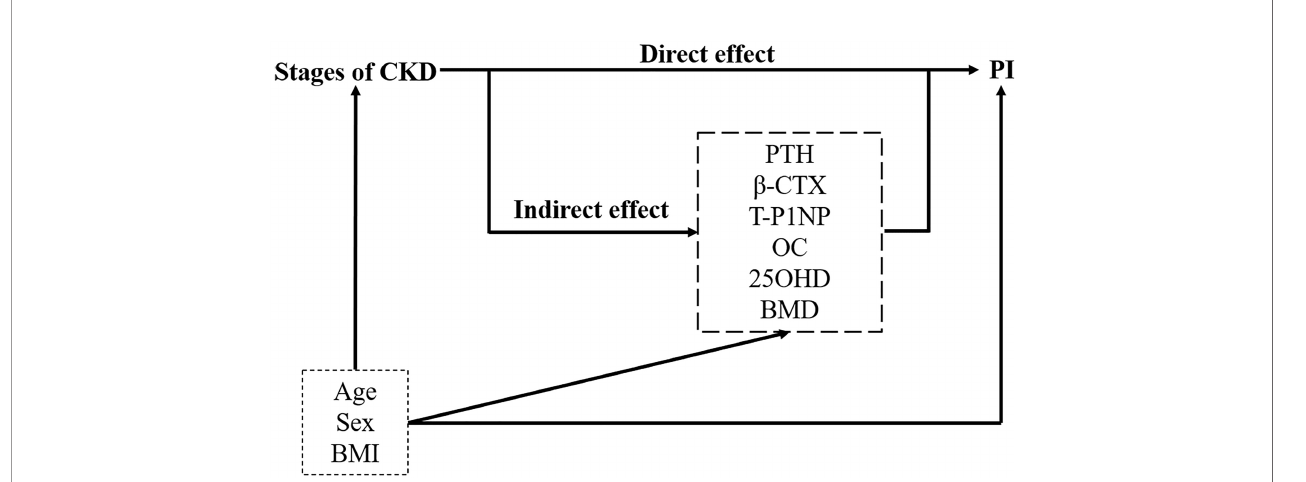
FIGURE 2 | Path diagram of the mediation relationship between grouping (the stages of CKD), mediators (bone metabolism markers and lumbar BMD) and outcome (PI). Adjusting for confounders: age, sex, and BMI. Direct and indirect effects are obtained from multiple linear regression. PTH, parathyroid hormone; b - CTX, b -CrossLaps; T-P1NP, total procollagen type I amino-terminal propeptide; OC, osteocalcin; 25OHD, 25-hydroxyvitamin D; BMD, bone mineral density; PI, porosity index.